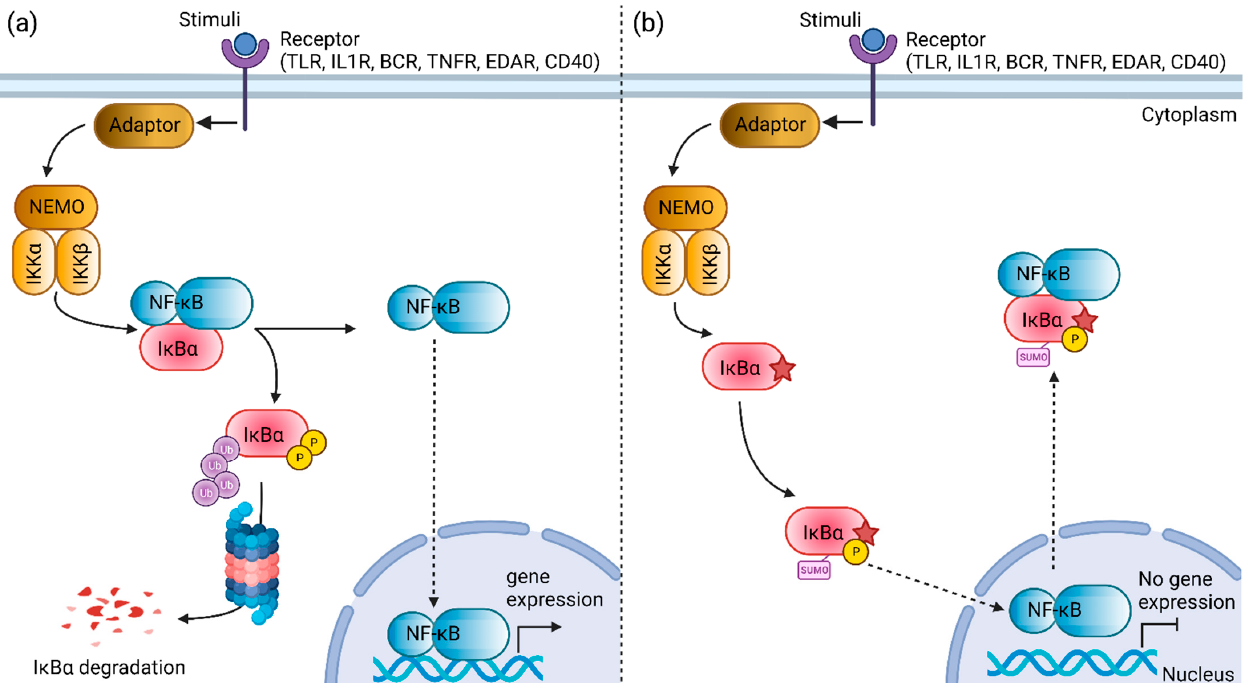
Figure 4. Schematic diagram illustrating the nuclear factor kappa B (NF- κ B) signaling pathway mediated by the NF- κ B inhibitor α (I κ B α ) protein. ( a ) The constitutive NF- κ B activation is mediated by the degradation of the I κ B α protein. ( b ) The mutant Ser32Cys I κ B α protein (star symbol) is speculated to exhibit changes in the post-translational modifications. The loss of phosphorylation site at residue 32 and introduction of a new sumoylation site at residue 38 may facilitate the nuclear transport of NF- κ B to the cytoplasm, resulting in the inhibition of NF- κ B activation. TLR, toll-like receptor; IL1R, interleukin-1 receptor; BCR, B cell receptor; TNFR, tumor necrosis factor receptor; EDAR, ectodysplasin A receptor; NEMO, NF- κ B essential modulator; IKK α , IkappaB kinase α subunit; IKK β , IkappaB kinase β subunit; NF- κ B, nuclear factor kappa B; I κ B α , NF- κ B inhibitor α . Created with BioRender.com, accessed on 30 July